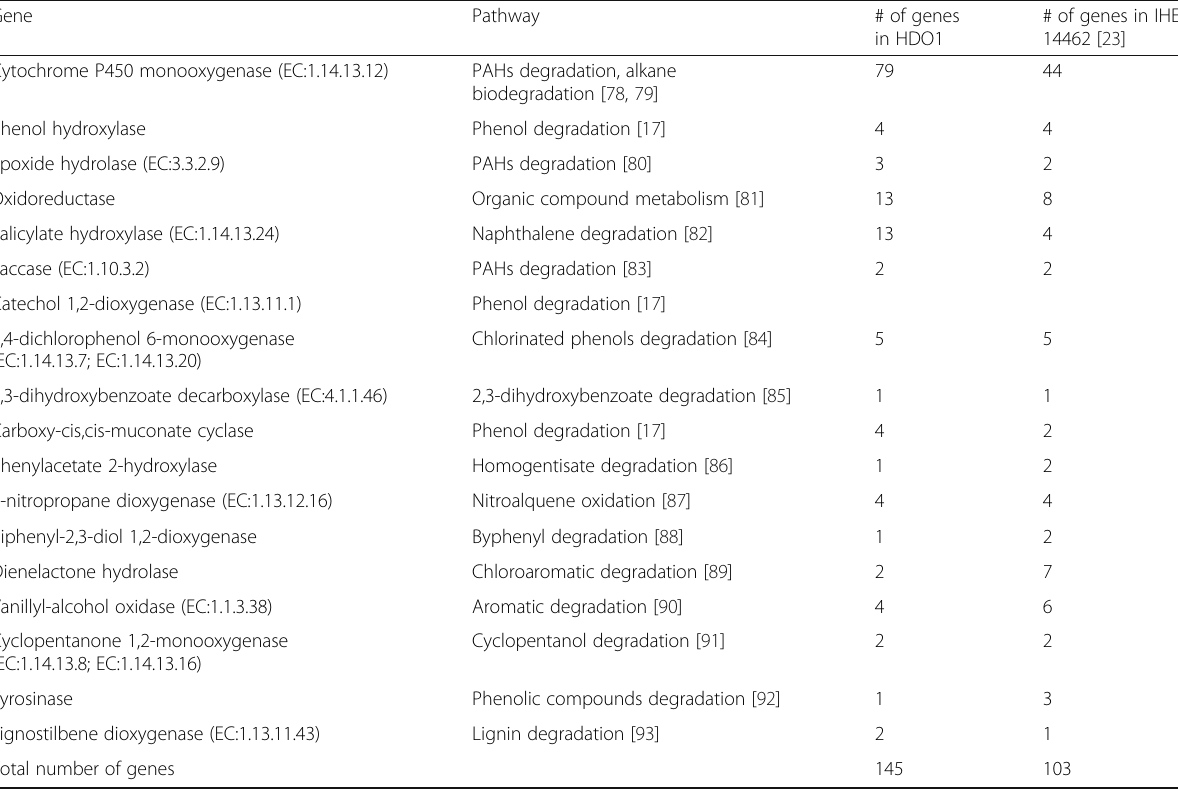
Table 6 Annotated genes involved in hydrocarbons degradation pathways Gene Pathway # of genes # of genes in IHEM in HDO1 14462 [23] Cytochrome P450 monooxygenase (EC:1.14.13.12) PAHs degradation, alkane 79 44 biodegradation [78, 79] Phenol hydroxylase Phenol degradation [17] 4 4 Epoxide hydrolase (EC:3.3.2.9) PAHs degradation [80] 2 Organic compound metabolism [81] 13